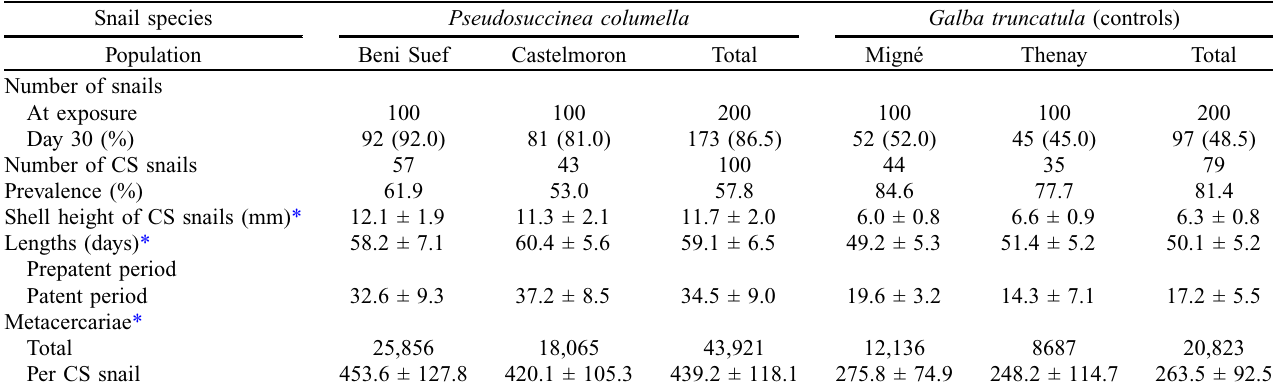
Table 2. Snail survival on day 30 post-exposure, prevalence of Fasciola hepatica infection, shell height of cercariae-shedding (CS) snails at their death, lengths of prepatent and patent periods, and number of metacercariae in four groups of pre-adults subjected to individual quinquemiracidial exposures and raised at 23 (cid:2)